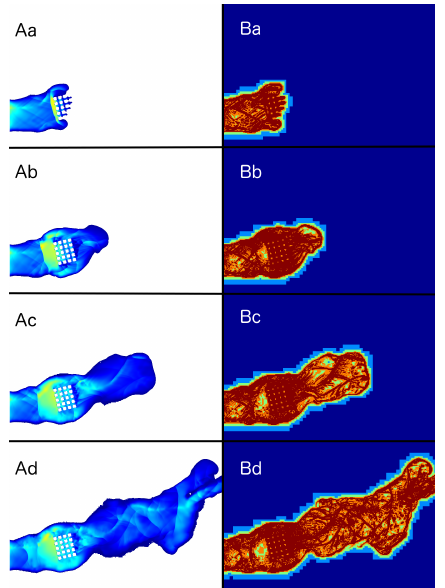
Figure 14. Picture of the water depth (A) and the refinement level (B) at t = 10s (a) , t = 13s (b) , t = 17s (c) , and t = 26s (d) . The minimum value for the water height (A) is 1cm, corresponding to the dark blue colour, and the maximum is 20cm, corresponding to the light blue colour. For the refinement level (B) , the minimum value is a cell of 23cm × 23cm, corresponding to the dark blue, and the maximum value is a cell of 1.5cm × 1.5cm, corresponding to